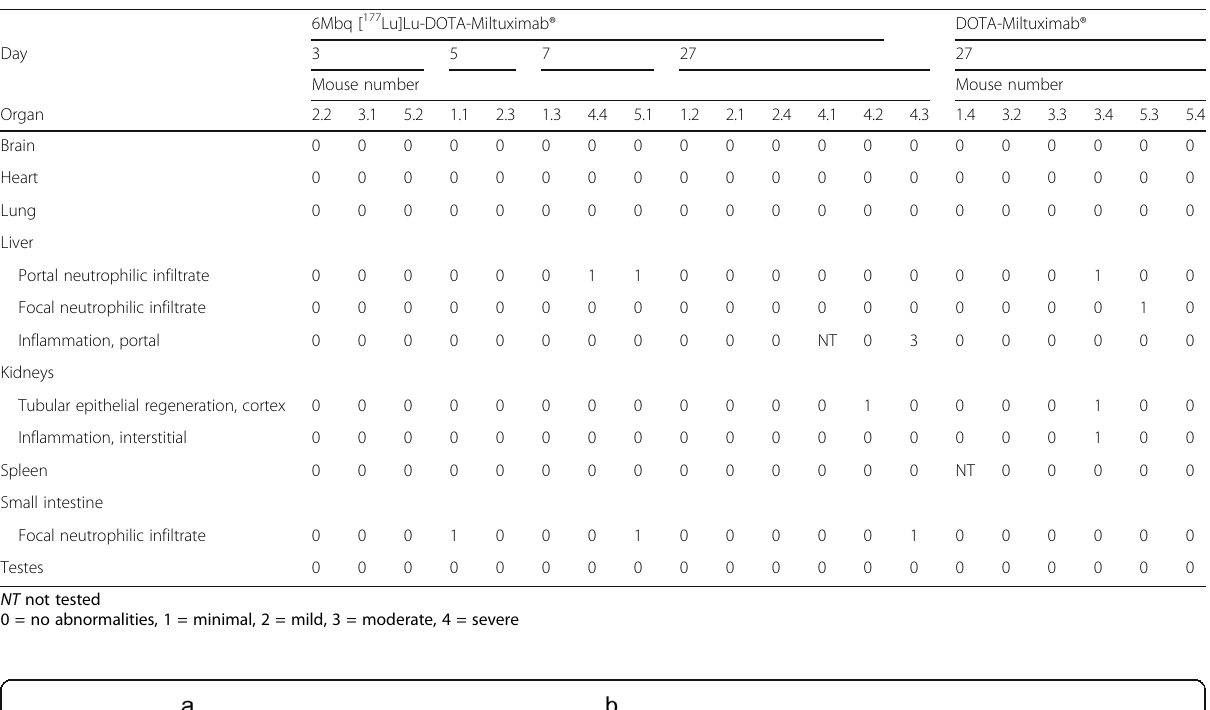
6Mbq [ 177 Lu]Lu-DOTA-Miltuximab®